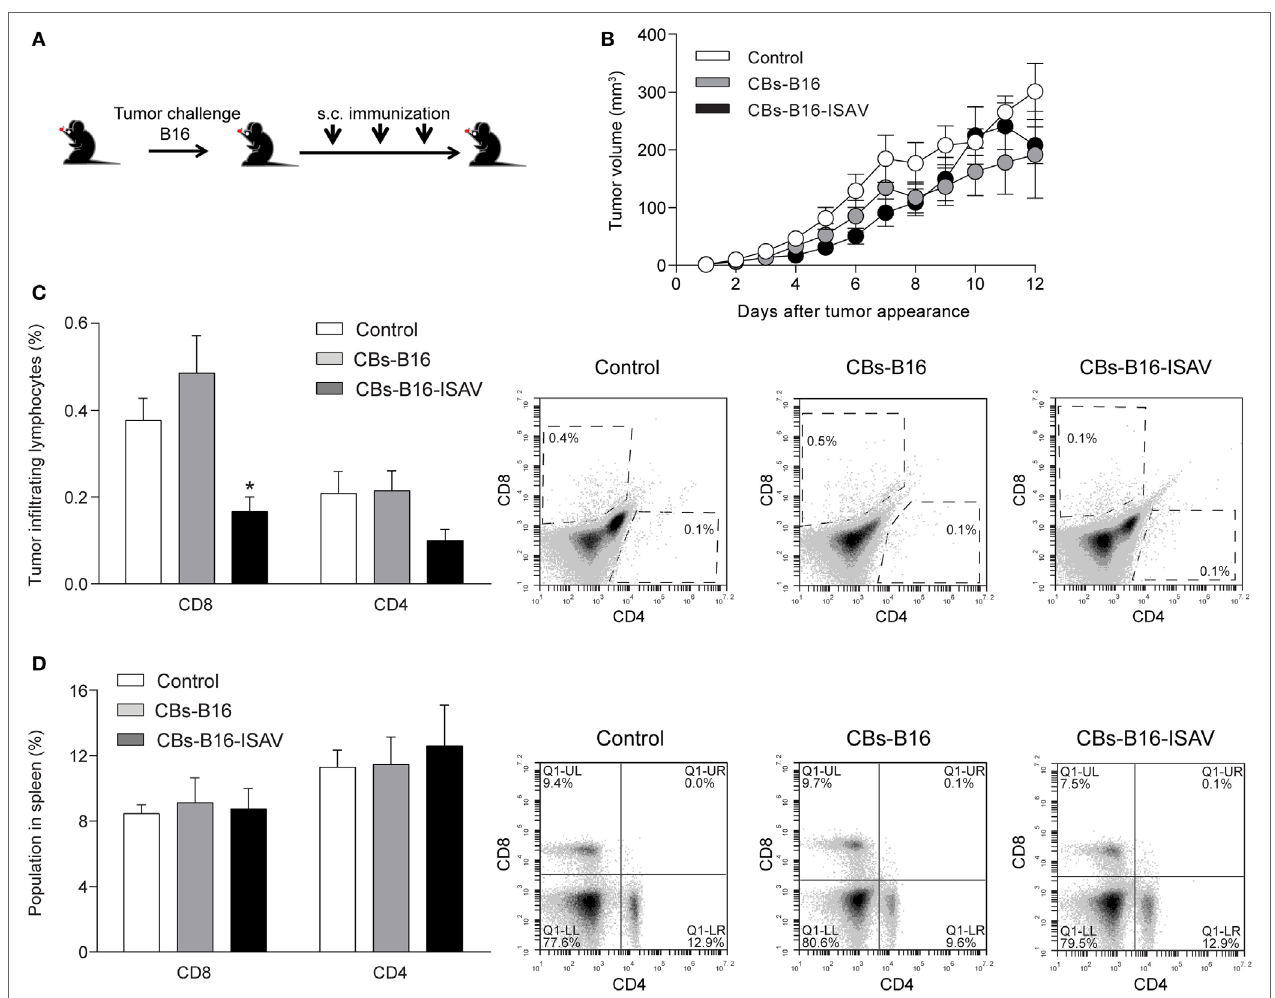
FigUre 5 | Effect of curative treatment with B16 and B16-ISAV cell bodies (CBs) in C57BL/6, challenged with B16 tumor cells. Schematic representation of the curative treatment. (a) C57BL/6 mice were challenged with 2 × 10 5 viable B16 cells and 7, 14, and 21 days after the challenge they were inoculated with 100 µL of cellular bodies (from 1 × 10 5 cells) generated from non-transfected or infectious salmon anemia virus (ISAV)-transfected cells. (B) Tumor growth after tumor appearance in C57BL/6 mice. (c) CD8 and CD4 tumor infiltrating lymphocytes in C57BL/6 mice treated with B16 CBs. (D) CD8 and CD4 spleen lymphocytes in C57BL/6 mice treated with B16 CBs. Statistical analyses were performed using Kruskal–Wallis ANOVA ( n = 6; * p <